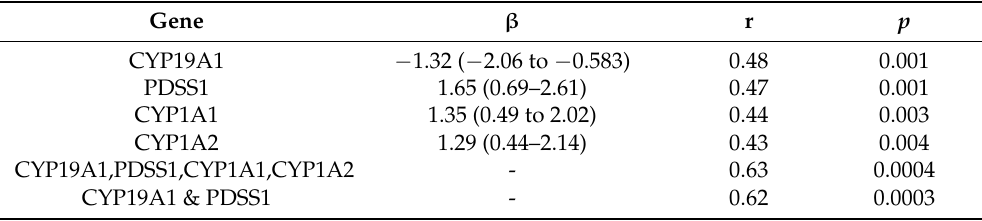
Table 7. Association of genes of the oestrogen pathway with the SERM-induced changes in spine BMD. Results of the linear regression of the most significant SNP in each gene, including both the univariate and multivariate analyses, are